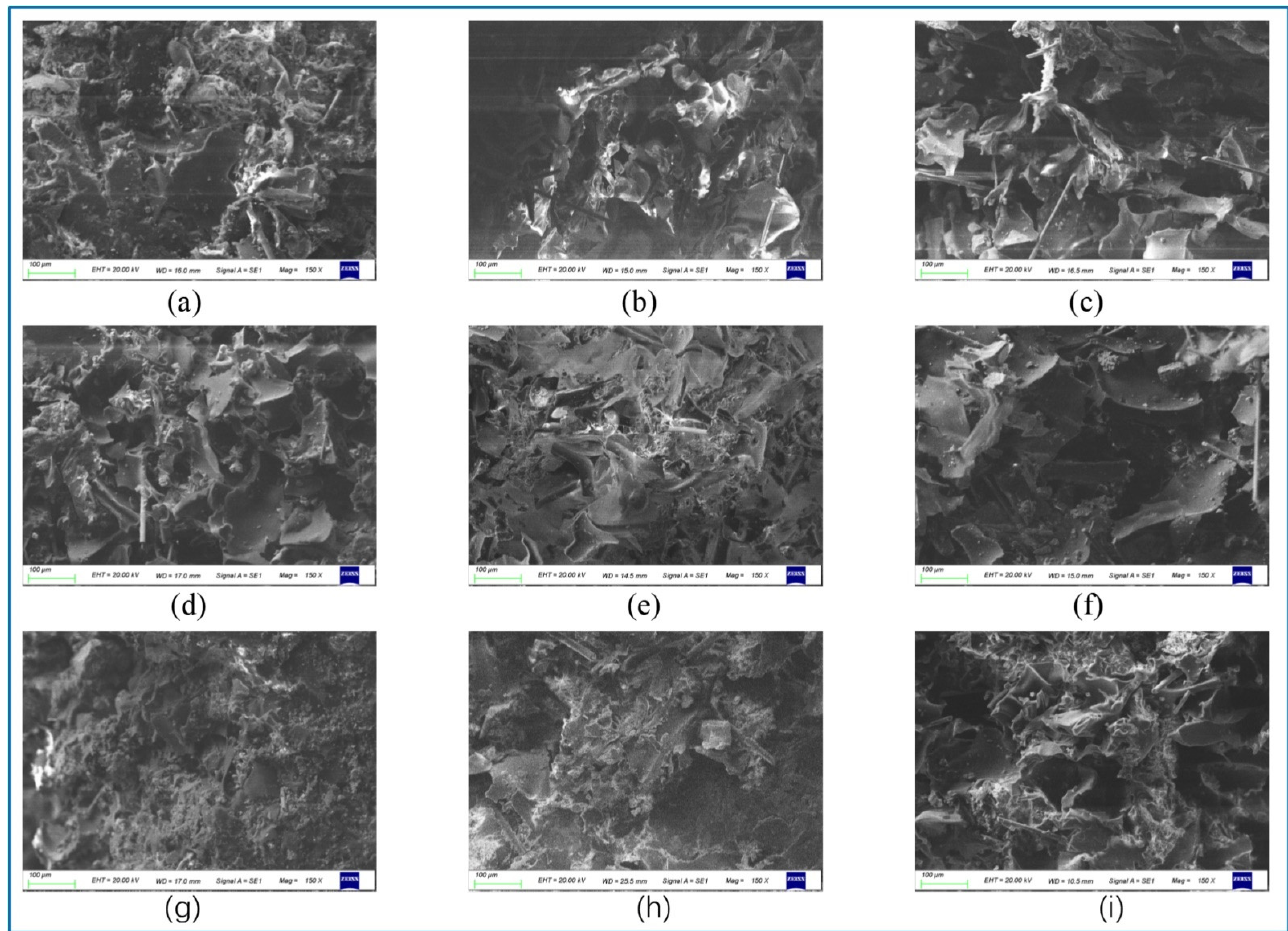
Figure 13. Photomicrographs for samples 1–9 (×150 magnification; ( a – i ) corresponds to experiments no. 1–9).